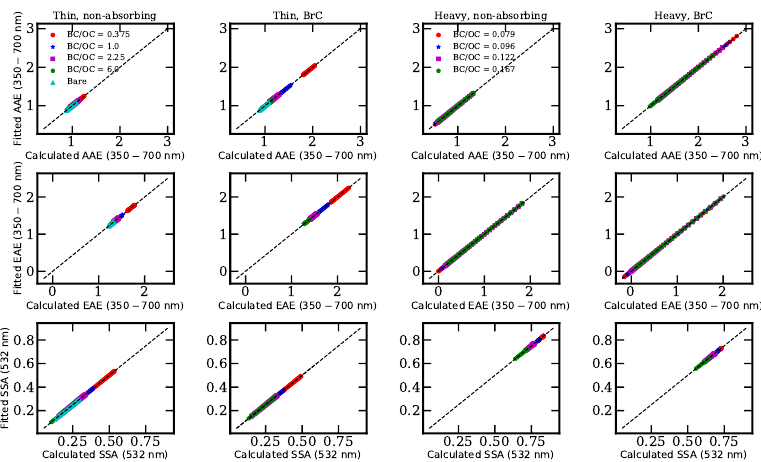
Figure 6. Comparison of the fitted radiative properties and those calculated using MSTM, σ g = 1.5, where correlation coefficients ( R 2 ) > 0.999 and normalized mean absolute error (NMAE) < 10 − 10 .